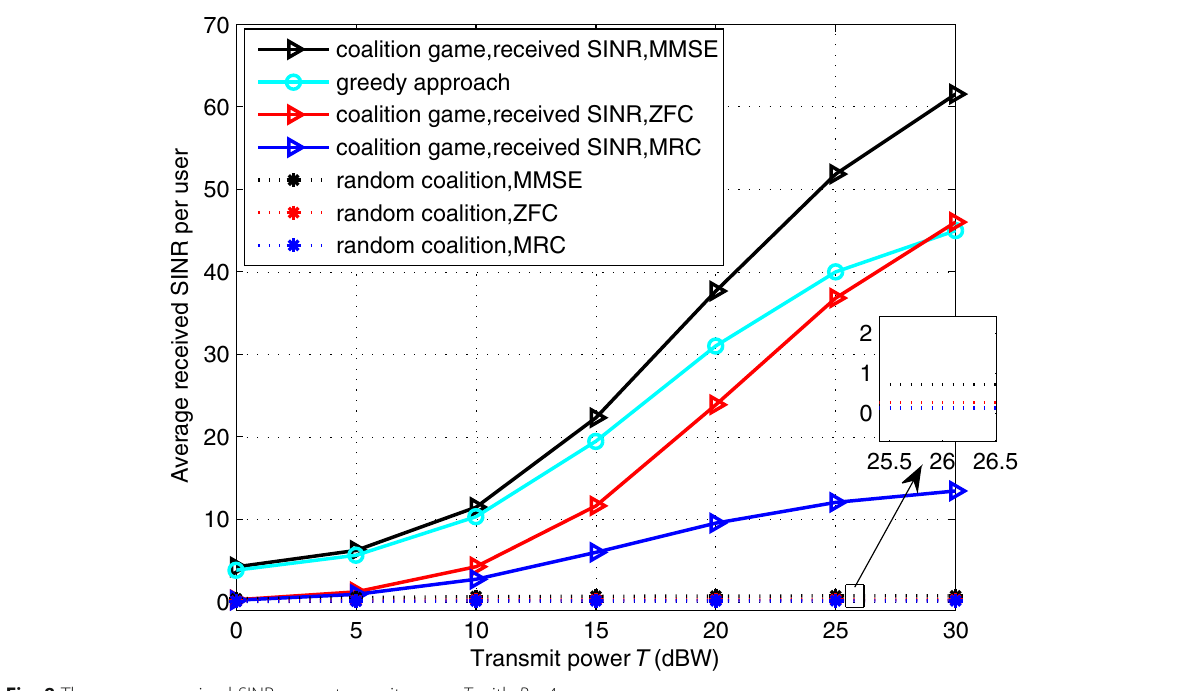
Fig. 8 The average received SINR versus transmit power T with P = 4